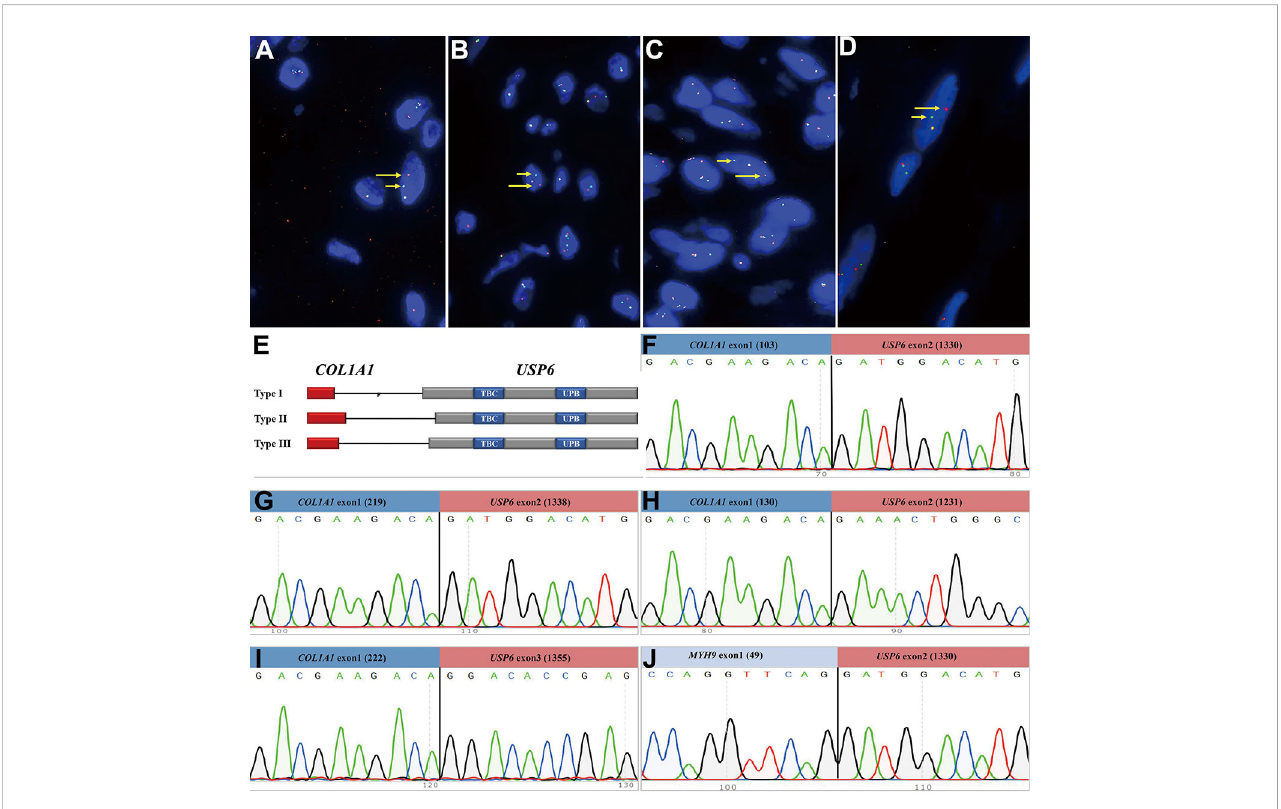
FIGURE 4 Findings of break-apart USP6 fl uorescence in situ hybridization and reverse transcription polymerase chain reaction for identifying common USP6 fusion partners. (A) Break-apart USP6 FISH showed split red (long arrow) and green (short arrow) signals in myositis ossi fi cans (Case 42). (B) USP6 FISH showed split red (long arrow) and green (short arrow) signals in fi bro-osseous pseudotumor of digits (Case 49). (C) USP6 FISH showed split red (long arrow) and green (short arrow) signals in soft tissue aneurysmal bone cyst (No. 60). (D) USP6 FISH showed split red (long arrow) and green (short arrow) signals in fasciitis ossi fi cans (No. 63). (E) Diagram showing the overall structure of COL1A1::USP6 fusion genes. (F) One myositis ossi fi cans (Case 22) showed the nucleotide (103, NM_000088) of COL1A1 exon 1 fused with a nucleotide (1330, NM_0004505) of USP6 exon 2 (type I). (G) One fasciitis ossi fi cans (Case 71) showed the last nucleotide (219, NM_000088) of COL1A1 exon 1 fused with a nucleotide (1338, NM_0004505) of USP6 exon 2 (type II). (H) One myositis ossi fi cans (Case 32) showed the last nucleotide (130, NM_000088) of COL1A1 exon 1 fused with a nucleotide (1231, NM_0004505) of USP6 exon 1 (type III). (I) One fasciitis ossi fi cans (Case 63) showed a nucleotide (222, NM_000088) of COL1A1 exon 1 fused with a nucleotide (1355, NM_0004505) of USP6 exon 3. (J) One myositis ossi fi cans (Case 42) showed the last nucleotide (49, NM_000088) of MYH9 exon 1 fused with a nucleotide (1330, NM_0004505) of USP6 exon